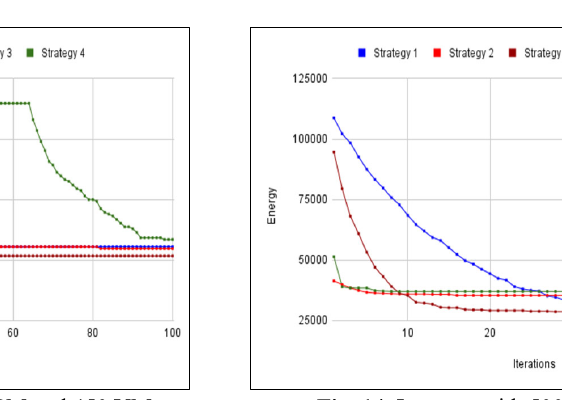
Fig. 13. Instance with 300 PM and 450 VM Fig. 14. Instance with 500 PM and 700 VM